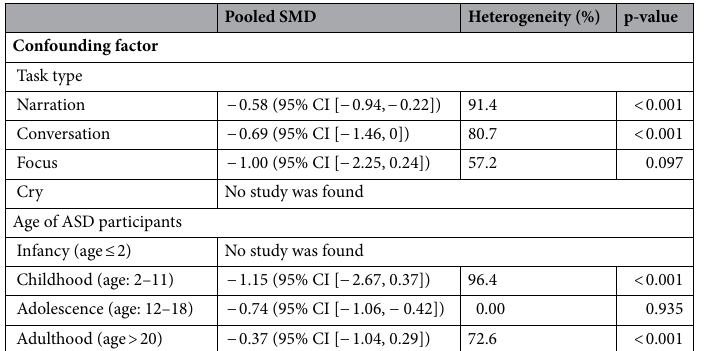
Table 4. Subgroup analysis for pitch range difference between ASD and TD groups. The elicitation tasks and the age of participants were confounding factors.